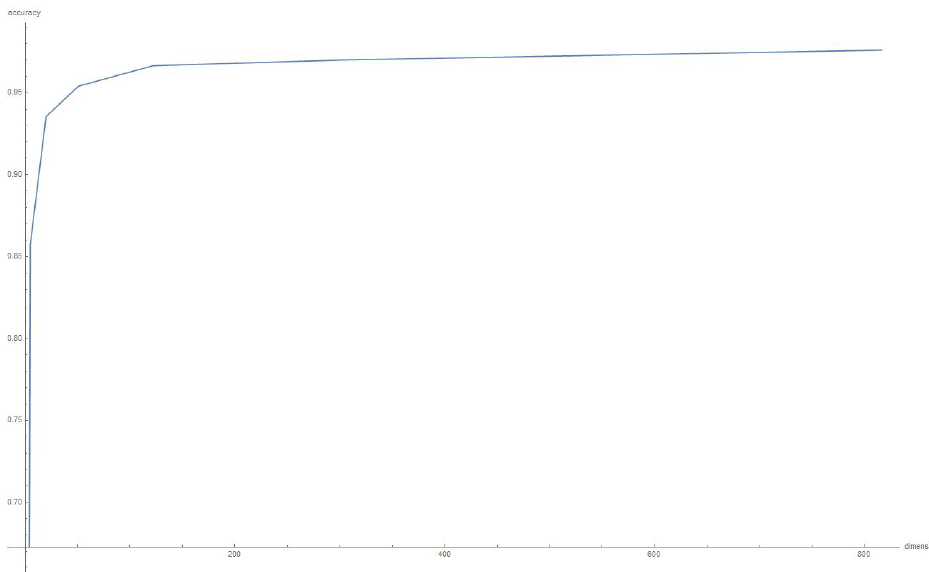
Figure 4. Accuracy of the Helstrom classifier as a function of the dimension of the space. In Figure 5, there is the decision boundary found by the Helstrom classifier, with misclassified points, in the lowest dimensional case. Figure 6 shows the output of an SVM with a linear kernel, and its behavior is confirmed as similar to the Helstrom classifier.